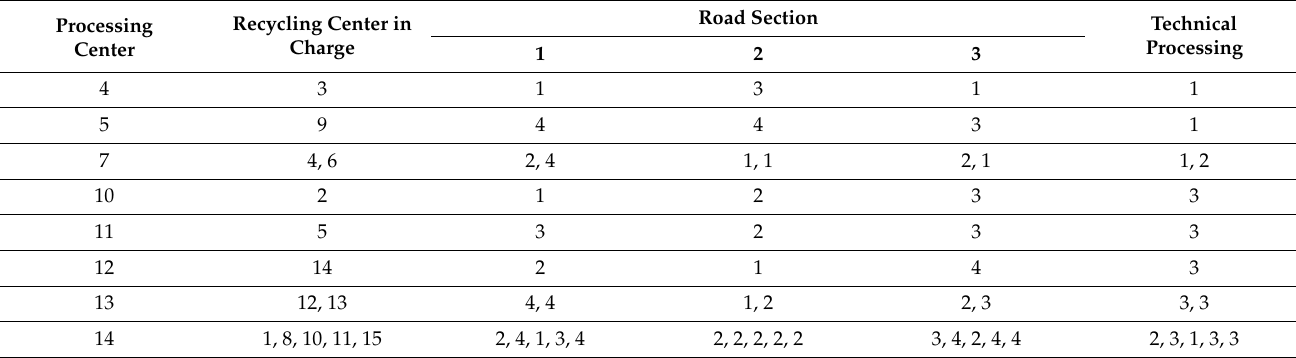
Table 10. Class I sample solution